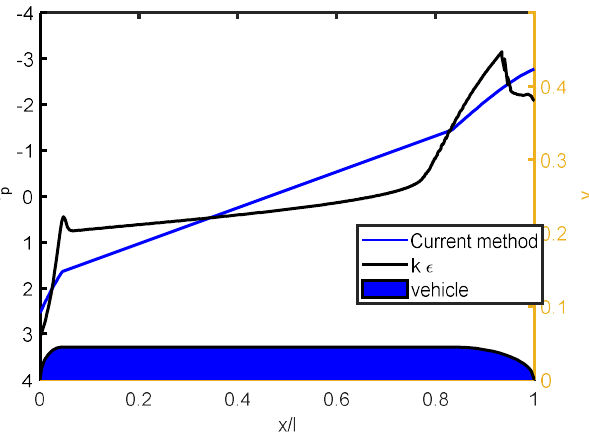
Figure 8. Pressure coefficient C p distribution at t = 1 s, M = 0.6, p = 10 kPa, β = 0.56.